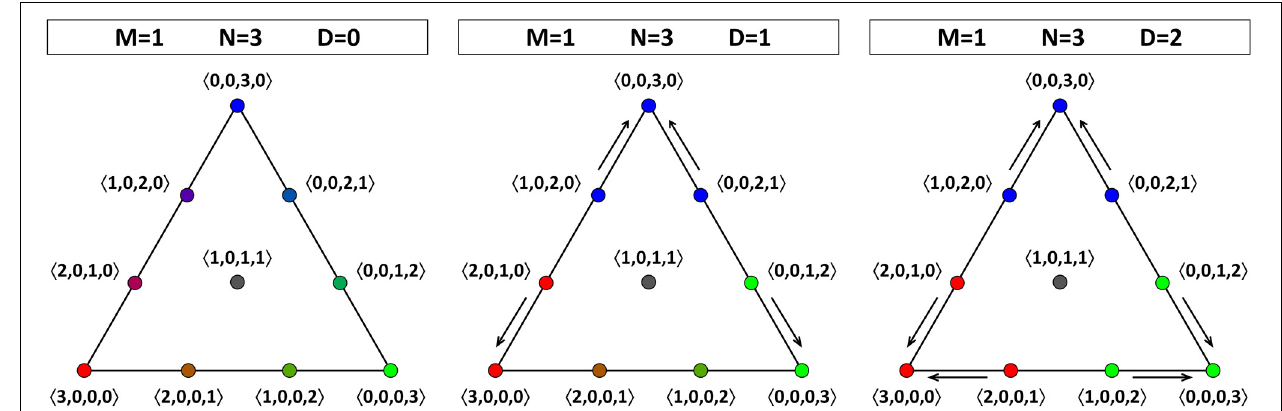
FIGURE 3 | Opinion dynamics for theories in a language with one atomic proposition ( M = 1) and a population consisting of three agents ( N = 3). One face of the OPS is shown. For D = 0 (left), there is no dynamics; all opinion profiles are fixed points. For D = 1 (middle), the three vertices act as sinks, but the points on the lower “double”